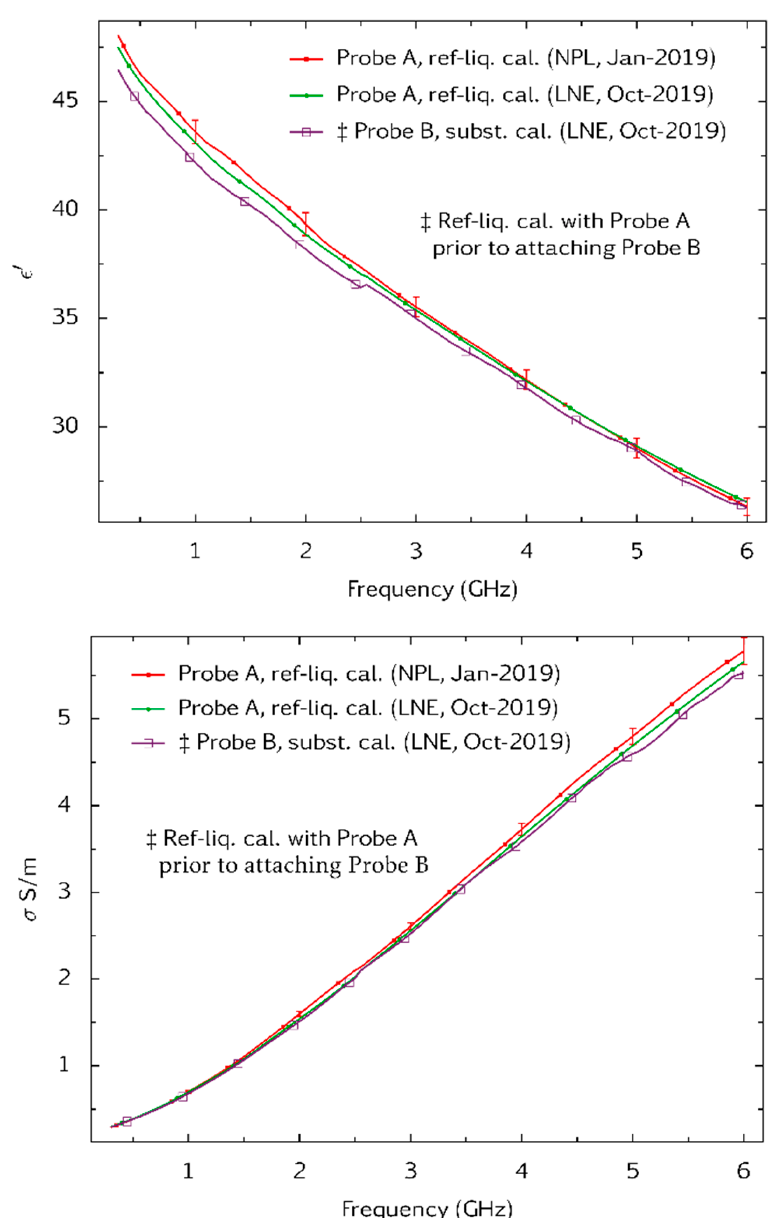
Figure 10. Measurements of the dielectric properties ε ’ ( top ) and σ ( bottom ) on the same sample of a tween-based tissue equivalent liquid. Measurements with Probe A were made at NPL and, after a 9-month interval, at Laboratoire National de Métrologie et d’Essais (LNE). Probe A was calibrated at both laboratories by the reference liquid method. LNE also measured the specimen with Probe B. Calibration of Probe B was by the substitution method using the calibration of Probe A and the coefficients 𝑎 , 𝑏 and 𝑐 in Equation (2) that were determined at NPL 9 months earlier. NPL and LNE used different vector network analyser models (a Rohde and Schwarz model ZVB20 VNA and an Agilent N5227A PNA respectively). Combined Type A and Type B uncertainties associated with the measurements obtained with Probe A are shown at a coverage factor of k = 2 (equivalent to 95% confidence level). These were evaluated by Monte-Carlo modelling [20].